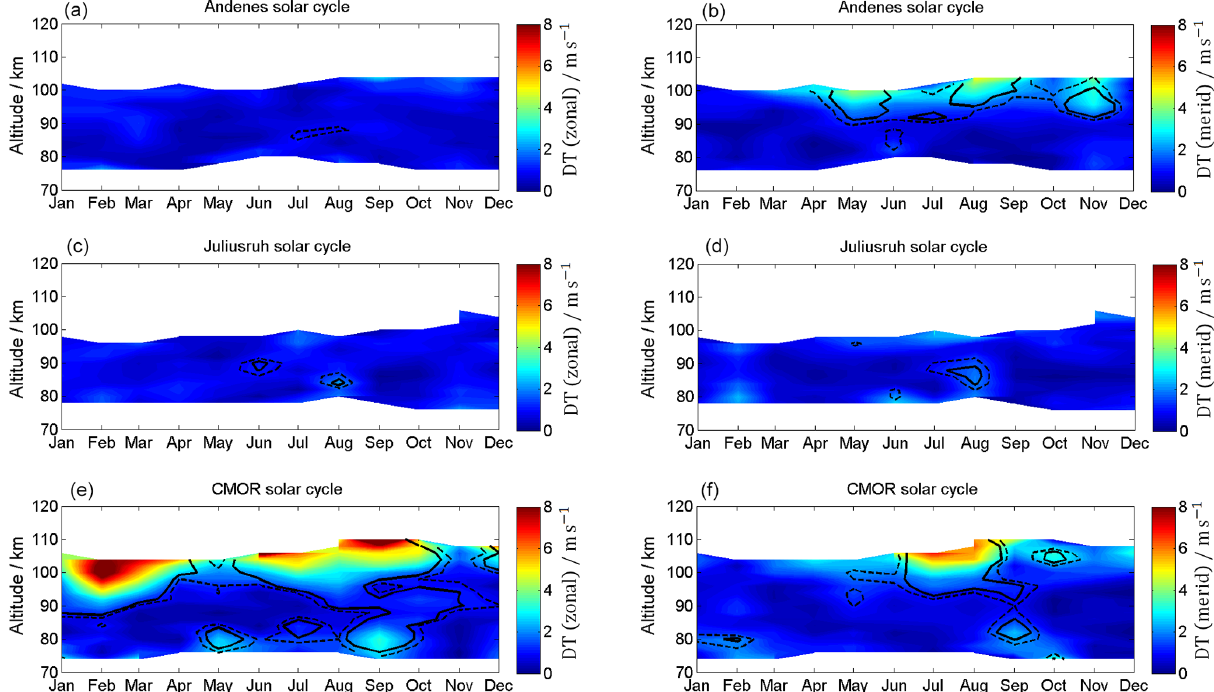
Figure 19. Linear change in an 11-year oscillation on the diurnal zonal (a, c, e) and meridional (b, d, f) tidal components for Andenes (a, b) , Juliusruh (c, d) , and CMOR (e, f) . The solid black lines corresponds to 95% significance, the dashed black lines to the 90%